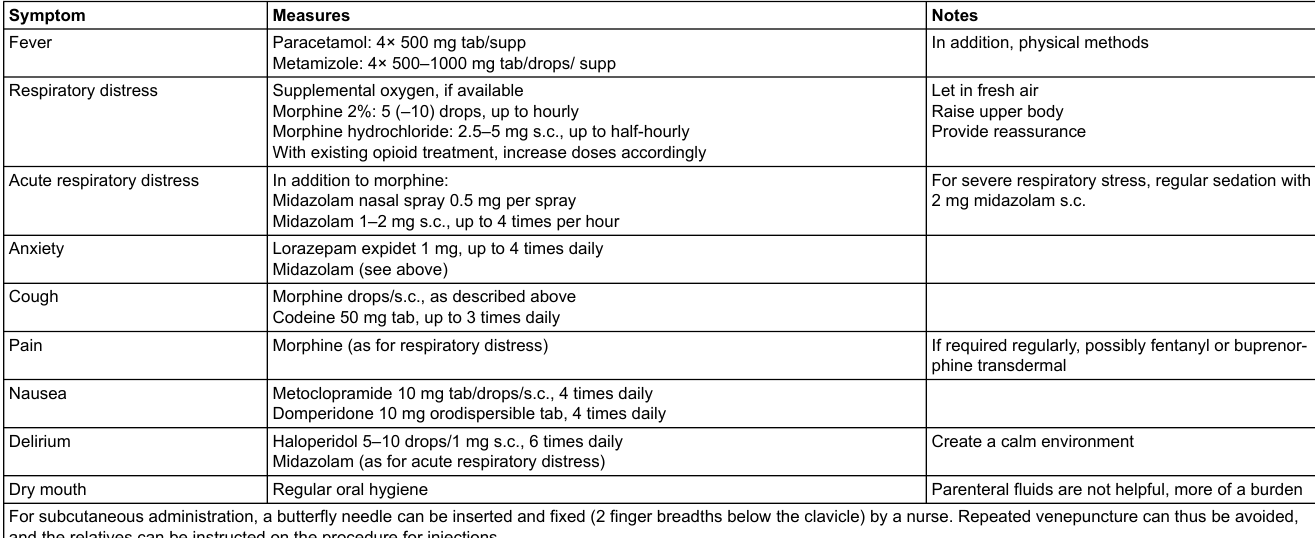
Table 1: Treatment recommendations for the most common expected symptoms (care provided by Spitex/relatives at home or by nursing staff in a home)